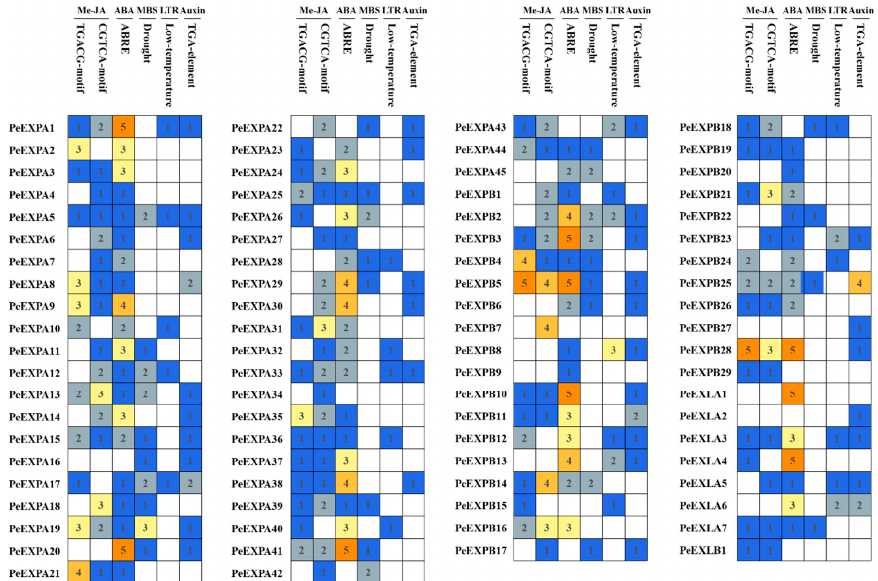
Figure 5. The numbers of promoter elements in the PeEXs’ promoter regions. Five major cis ‐ elements of PeEXs are indicated by different ‐ colored boxes with numbers. Int. J. Mol. Sci. 2020 , 21 , x FOR PEER REVIEW